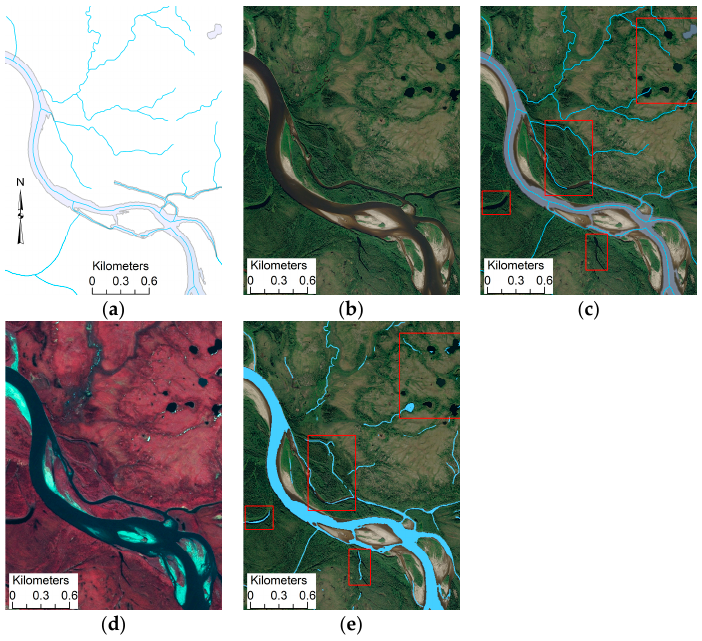
Figure 14. Shown for a low-relief area near the Kobuk River are ( a ) reference hydrography, ( b ) 0.5-m resolution color images from Maxar satellite, ( c ) reference hydrography over 0.5-m Maxar image, ( d ) 2.5-m color-infrared SPOT image, and ( e ) U-net predictions (sky blue) from model 14 over the 0.5-m resolution Maxar image. Red rectangles highlight areas in c where reference hydrography appears not well integrated with satellite information and areas in e where predictions deviate from reference hydrography but may better integrate with satellite